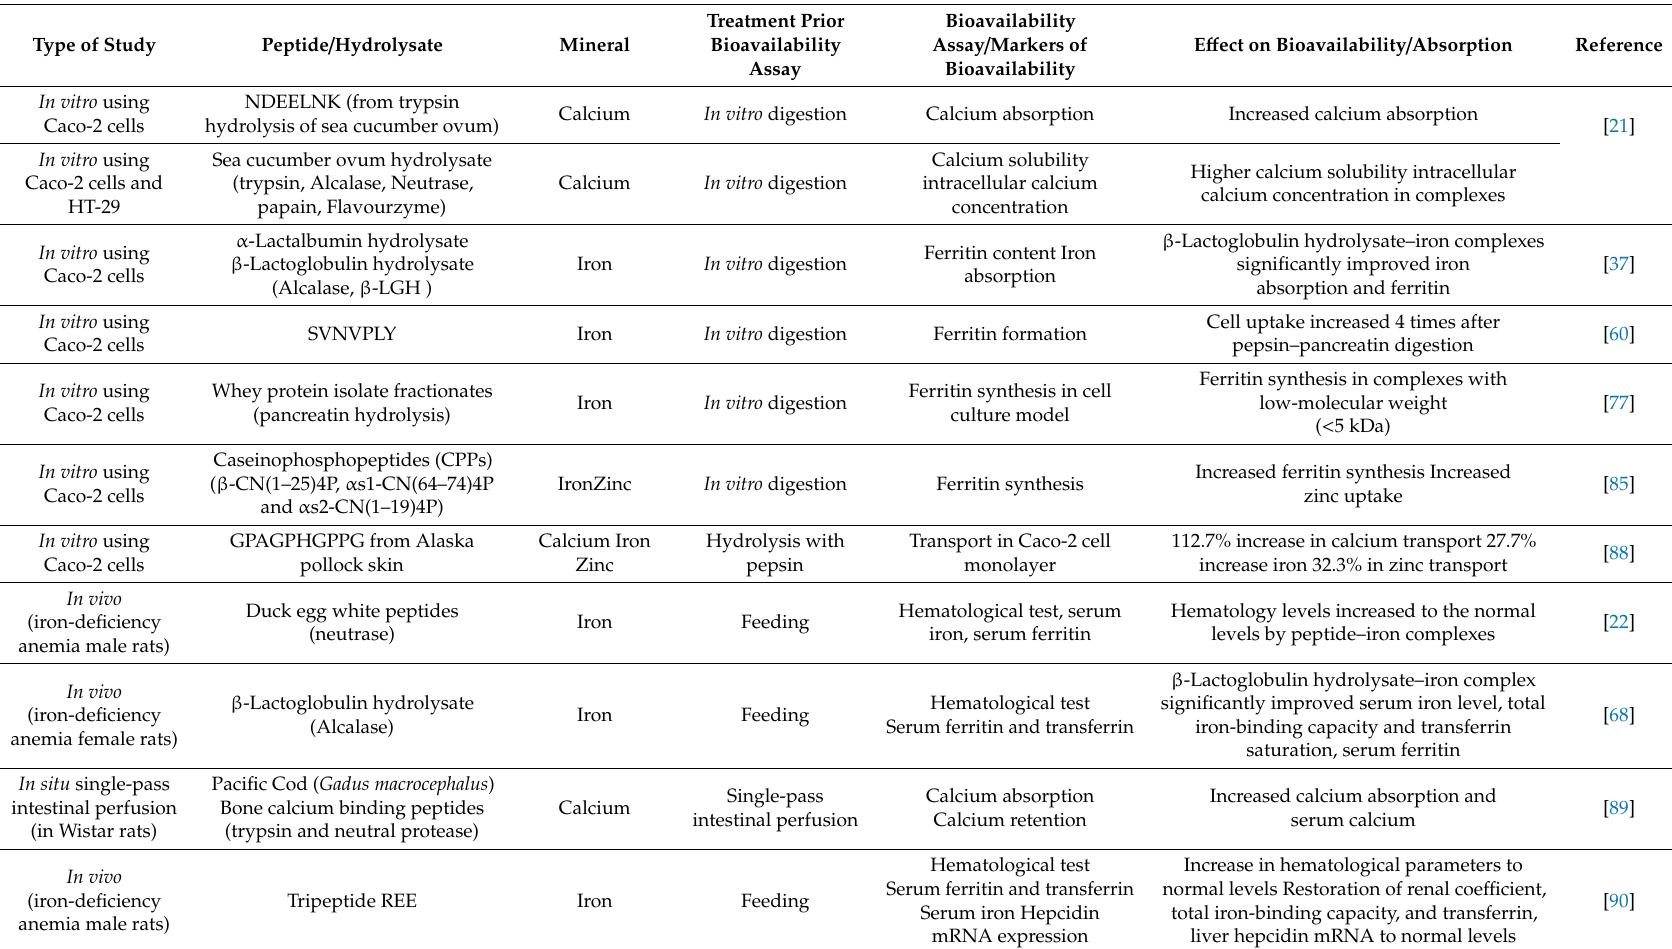
Table 2. E ff ect of preformed peptide–mineral complexes on the cellular uptake and bioavailability of